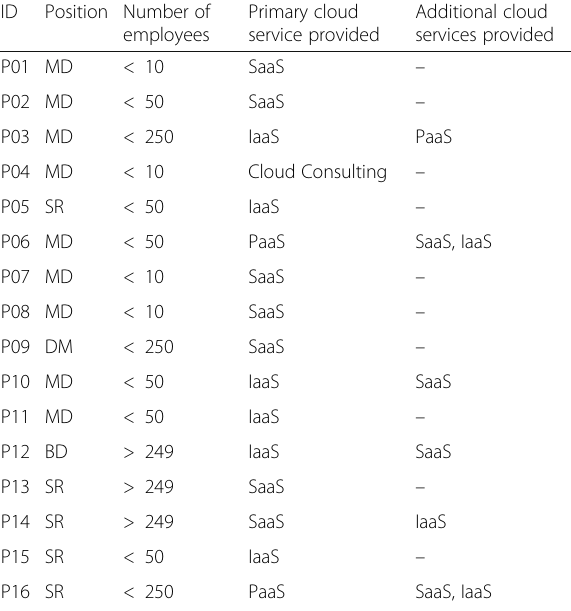
Table 2 Overview of